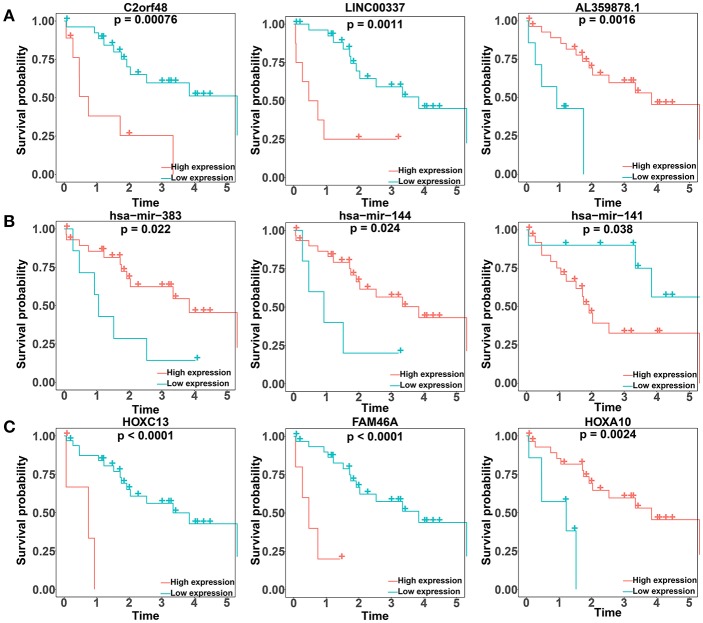
Kaplan–Meier survival curves for the top three lncRNAs, miRNAs, and mRNAs related to overall survival based on their optimal cutoffs in cholangiocarcinoma. The horizontal axis represents the overall survival time in years; the vertical axis represents the survival probability.